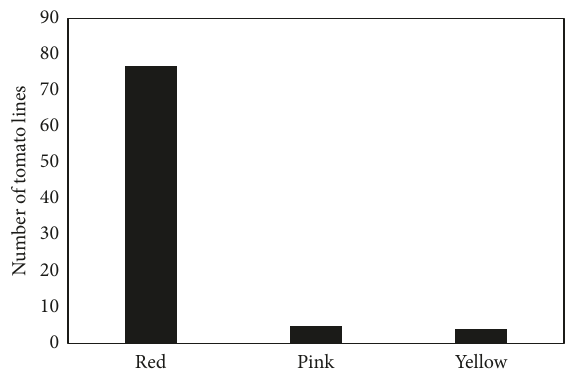
Figure 10: Distribution of ninety-one fresh-market tomato geno- types based on ripe fruit color.